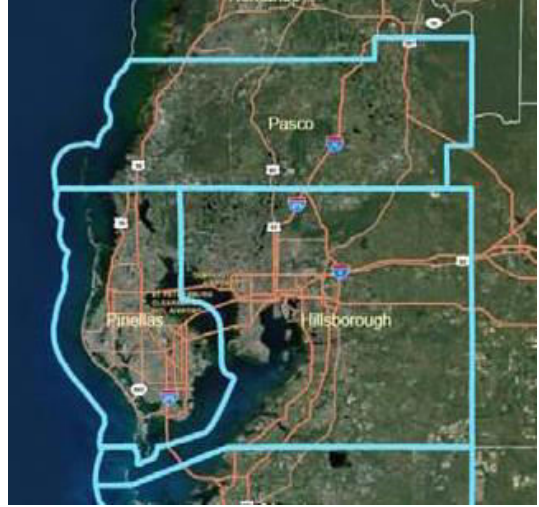
Figure 1 The case study area for the Tampa Bay Region Figure 2 The two feet SLR inundation map, FL under 2035 Sea